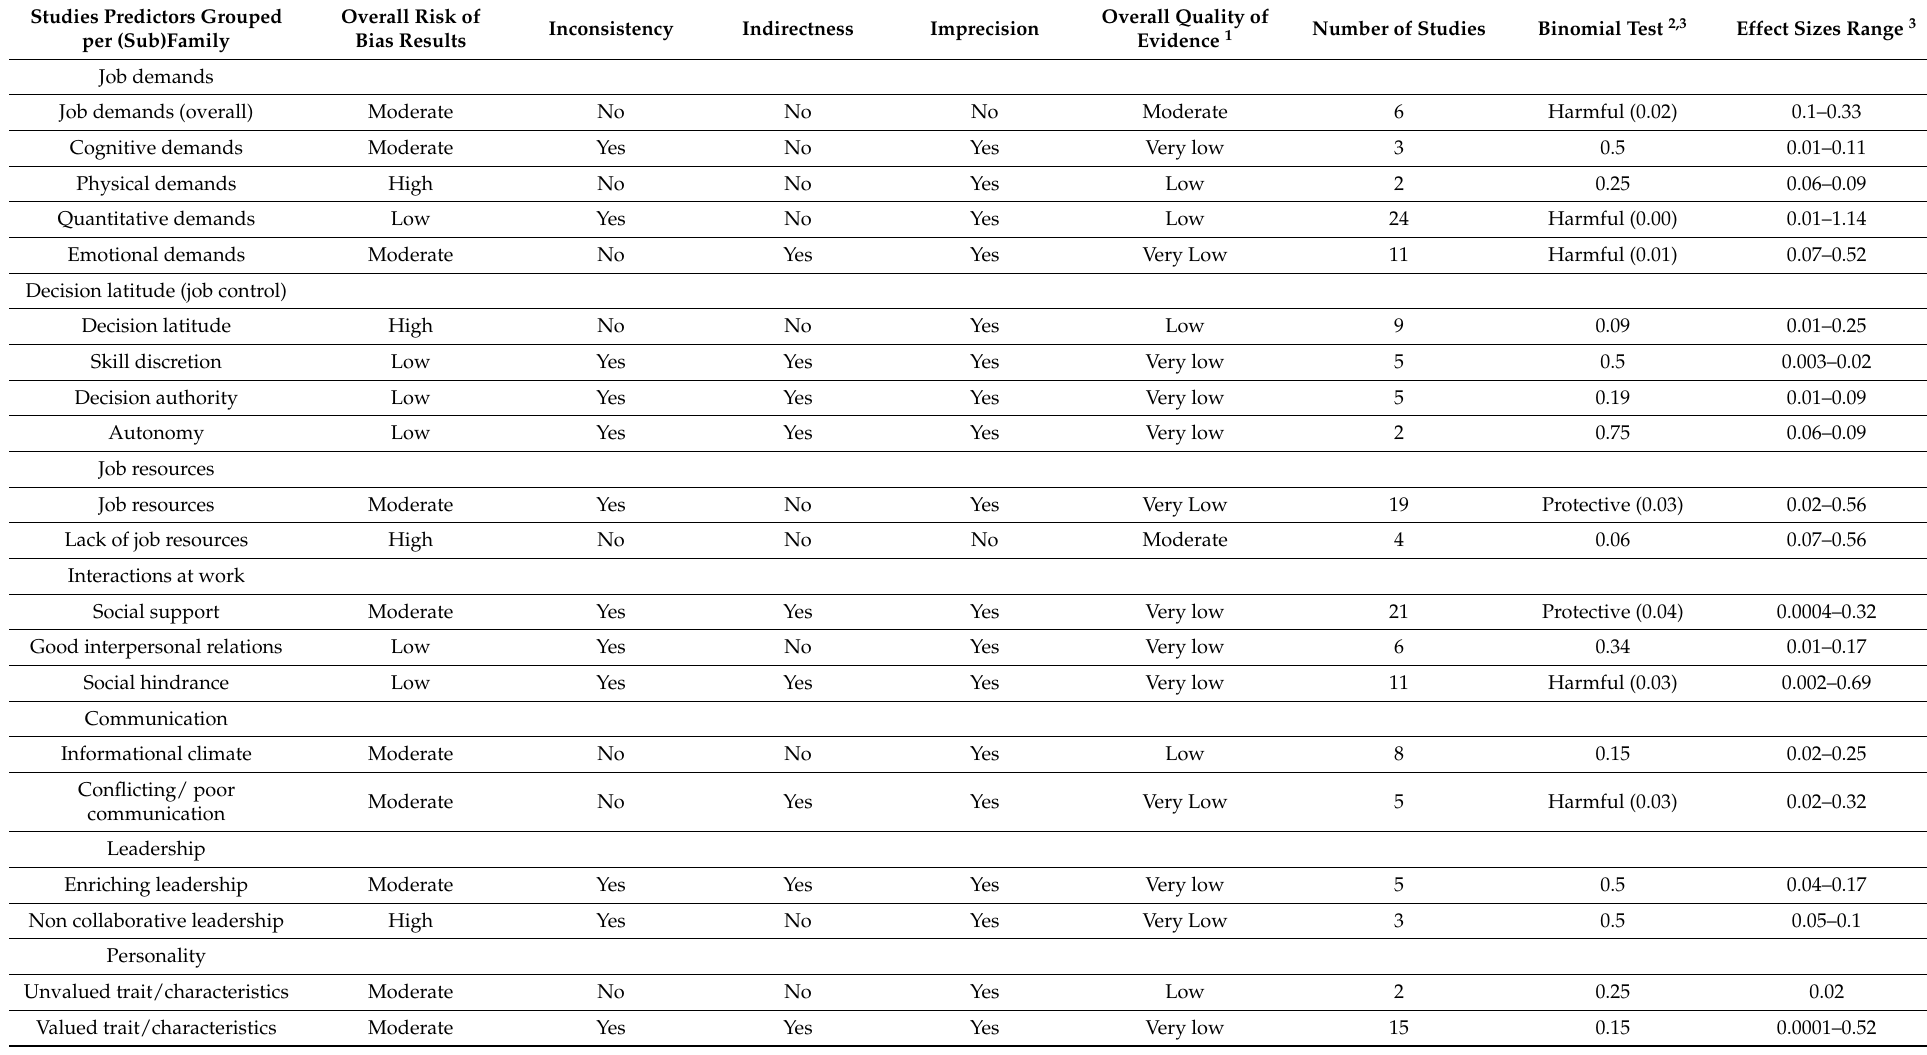
Table 1. Summary of quantitative and qualitative analysis of the included studies predictors grouped per